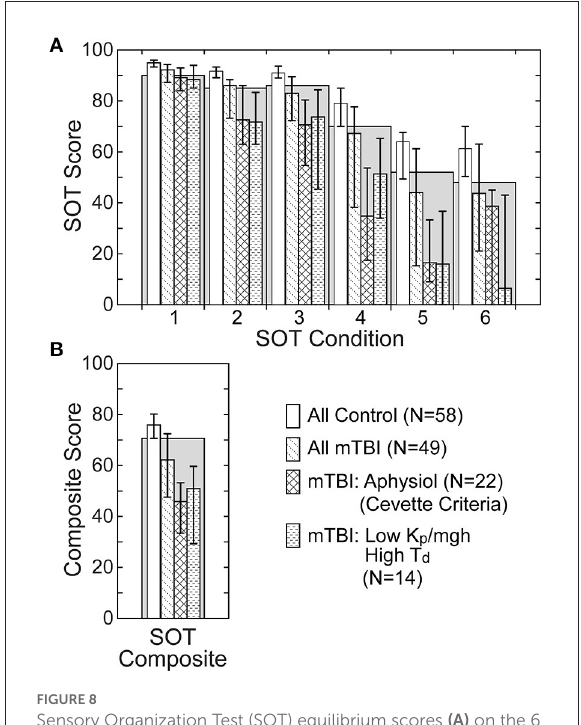
FIGURE8 Sensory Organization Test (SOT) equilibrium scores (A) on the 6 SOT conditions and composite scores (B) for all healthy control subjects, all mTBI subjects, mTBI subjects classified as having an Aphysiologic pattern of SOT results using the criteria defined by Cevette et al. (42), and mTBI subjects with low normalized stiffness ( K p / mgh ) and long time delay ( T d ) parameters on the CSMI SS/EC test condition. Gray bars show the clinical 5 th percentile limit of SOT equilibrium scores for subjects aged 20–59 years (41). Bars for the various subject groups show median values with error bars indicating the range defined by 25 th and 75 th percentile